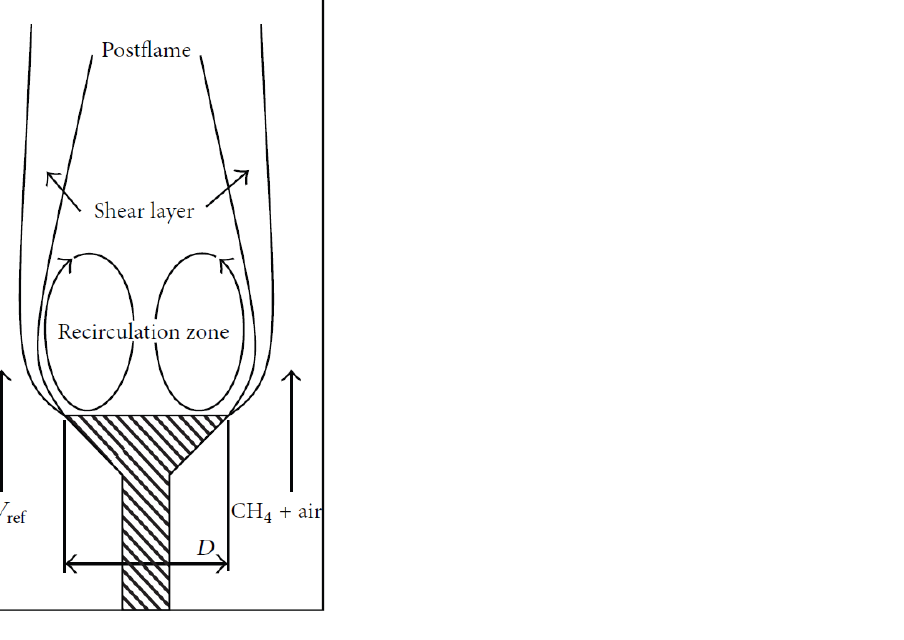
Figure 1. A schematic diagram of the bluff-body stabilised lean premixed combustor